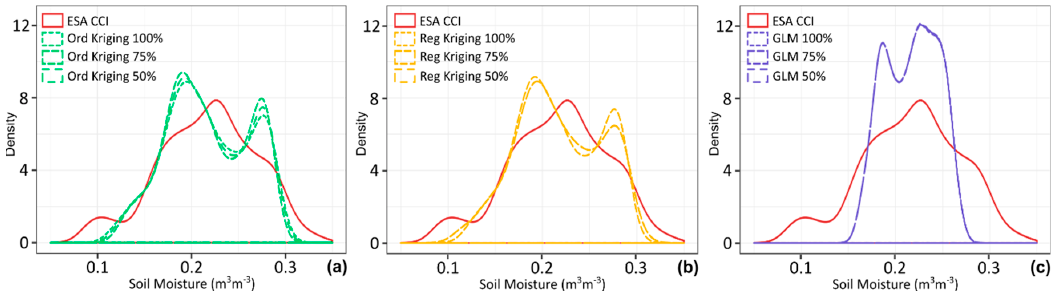
Figure 11. Density distribution of mean soil moisture values during the study period for 741 pixels over the region interest. ( a ) ESA CCI and modeled data using OK with 100%, 75%, and 50% of available valid data; ( b ) ESA CCI and modeled data using RK with 100%, 75%, and 50% of available valid data; ( c ) ESA CCI and modeled data using GLM with 100%, 75%, and 50% of available valid data.